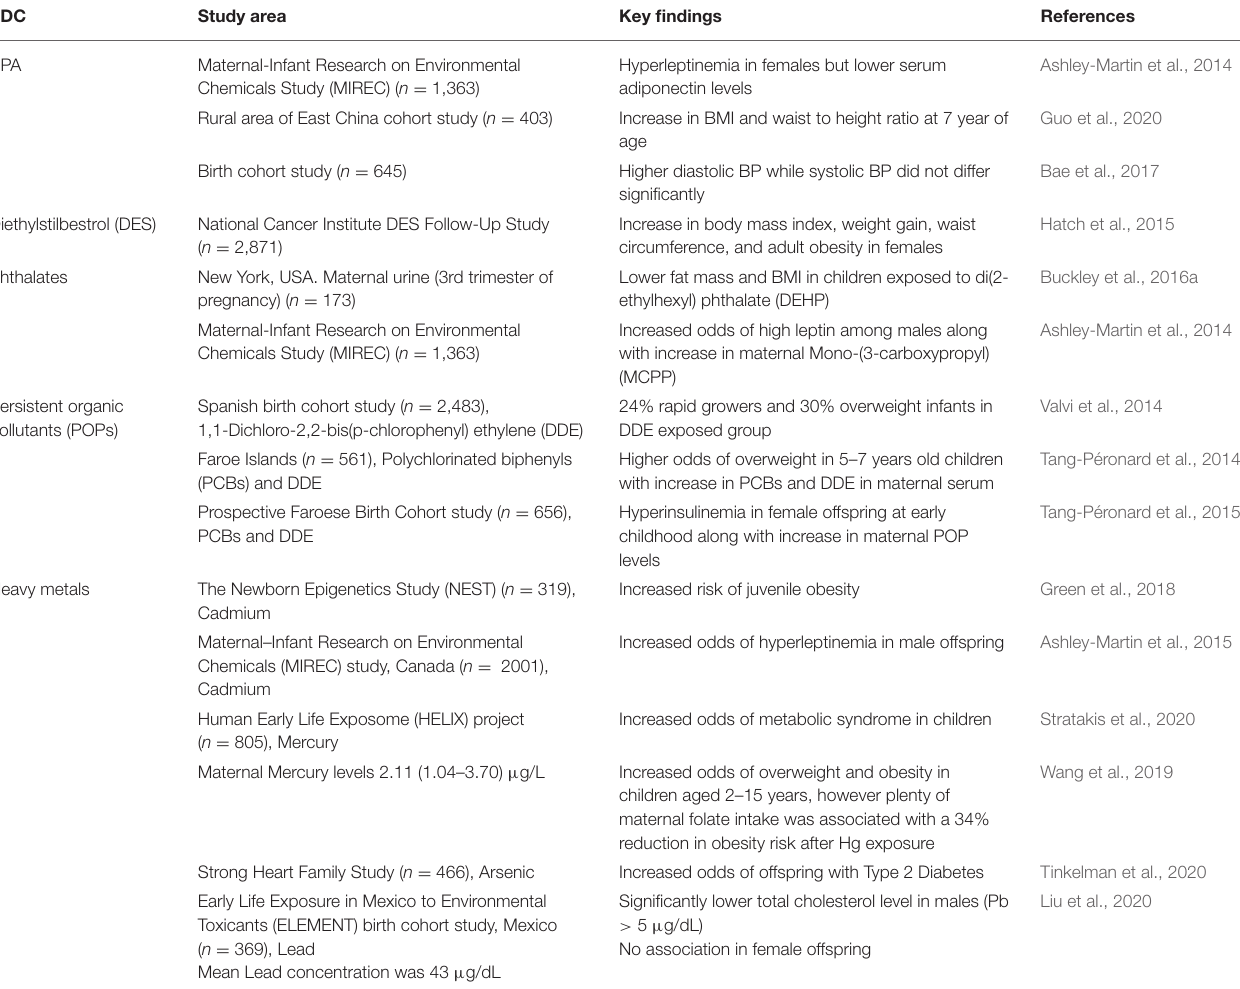
TABLE 1 | Epidemiological studies on maternal exposure to EDCs and risk of metabolic